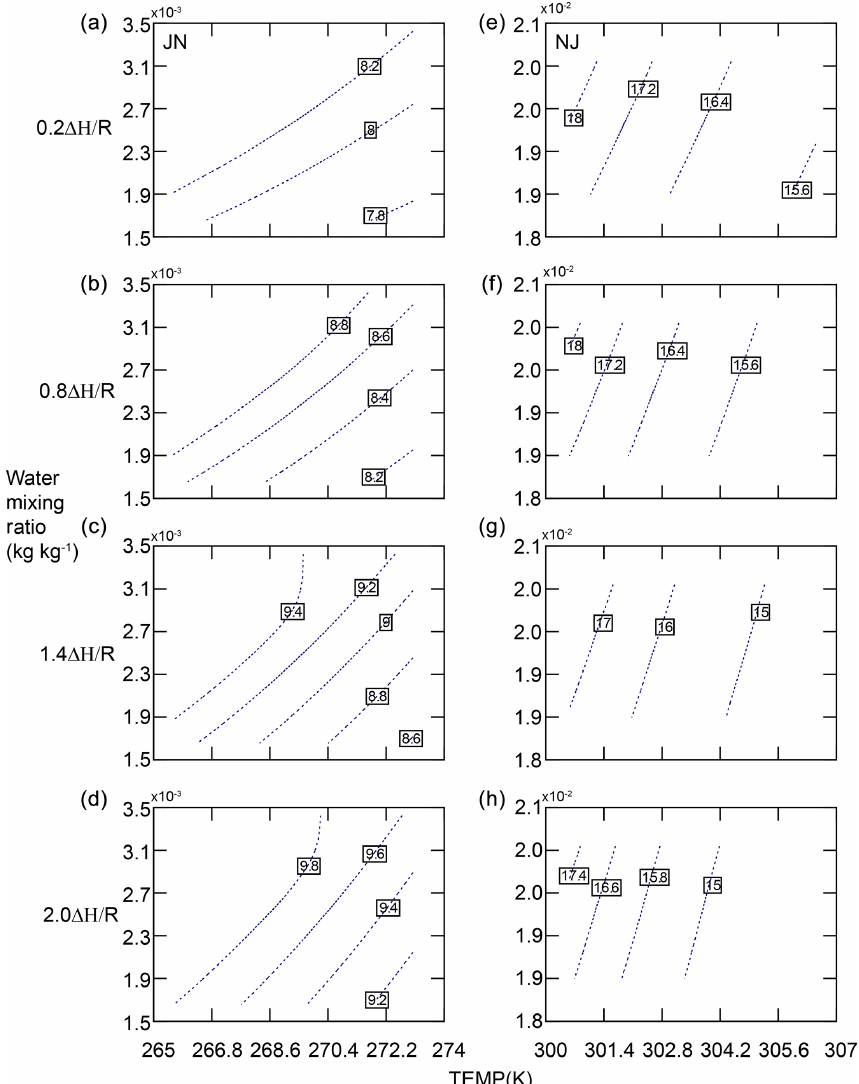
Figure 7. The sensitivity of SOA formation to temperature (TEMP), water mixing ratio, and the temperature dependence parameter of SVP ( (cid:49)H/R ) at Jinan (JN, a–d ) and Nanjing (NJ, e–h